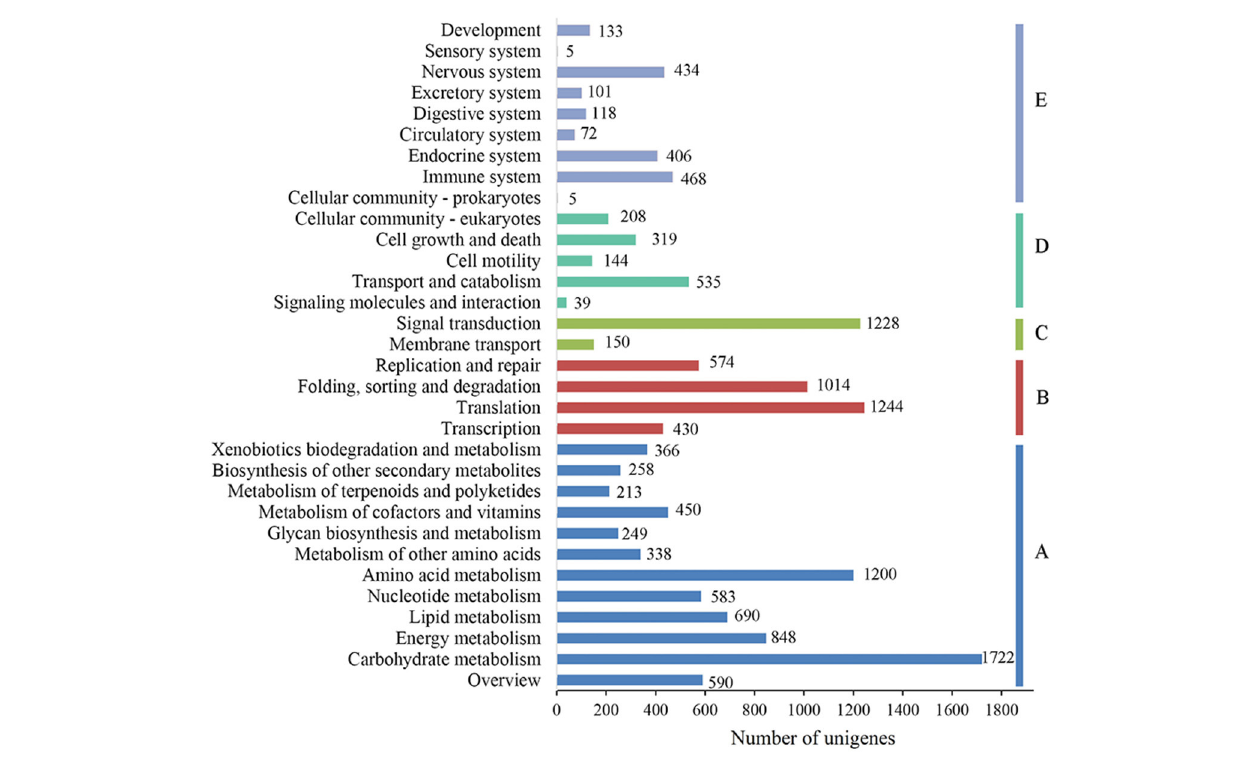
FIGURE 6 | KEGG function classification results of the annotated unigenes in Alopecurus aequalis . The y-axis lists the various KEGG pathways. The x-axis indicates the number of genes. According to their participation in these KEGG pathways, the unigenes were divided into five color-coded groups: metabolism (A) , genetic information processing (B) , environmental information processing (C) , cellular processes (D) , and organismal systems (E) .